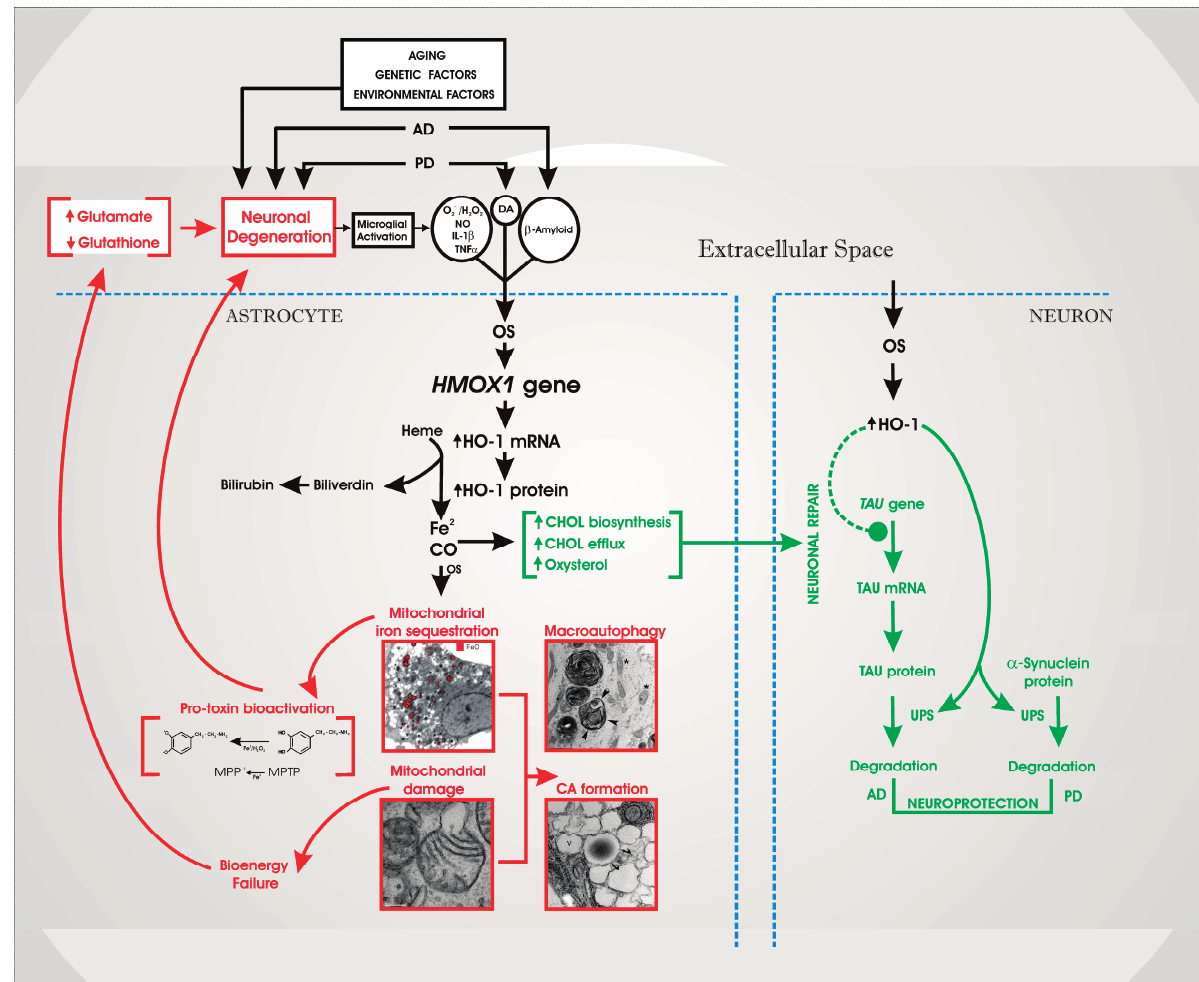
Figure 7. Putative roles of astroglial HO-1 in chronic human CNS disorders. Implications for AD and PD are emphasized. See text for details. AD, Alzheimer disease; CO, carbon monoxide; DA, dopamine; Fe 2 , ferrous iron; GSH, glutathione; HO-1, heme oxygenase-1; IL-1 β , interleukin-1b; MPP+, methyl-4-phenylpyridinium; MPTP, 1-methyl- 4-phenyl-1,2,3,6-tetrahydropyridine; NO, nitric oxide; OS, oxidative stress; PD, Parkinson disease; TNF α , tumor necrosis factor- α . (Modified from [27], with